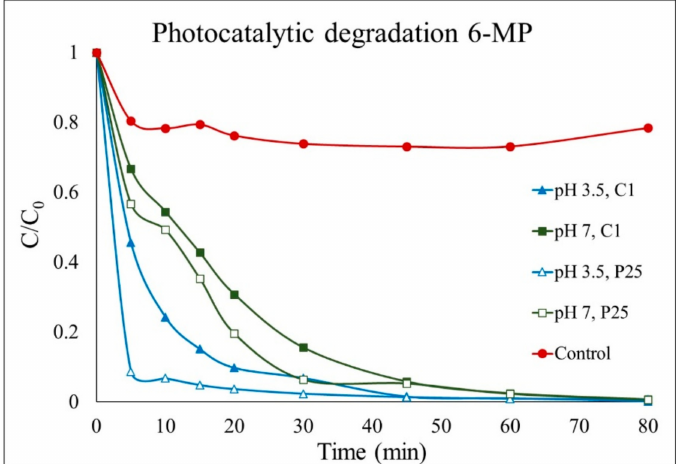
Figure 5. Degradation of 6-mercaptopurine (6-MP) after 80 min of reaction in a flat-bed reactor with an area of 1 / 10 m 2 , with two photocatalysts (TiO 2 P25 and C1-TiO 2 ), two pH magnitudes (3.5 and 7) and a H 2 O 2 dose of 3